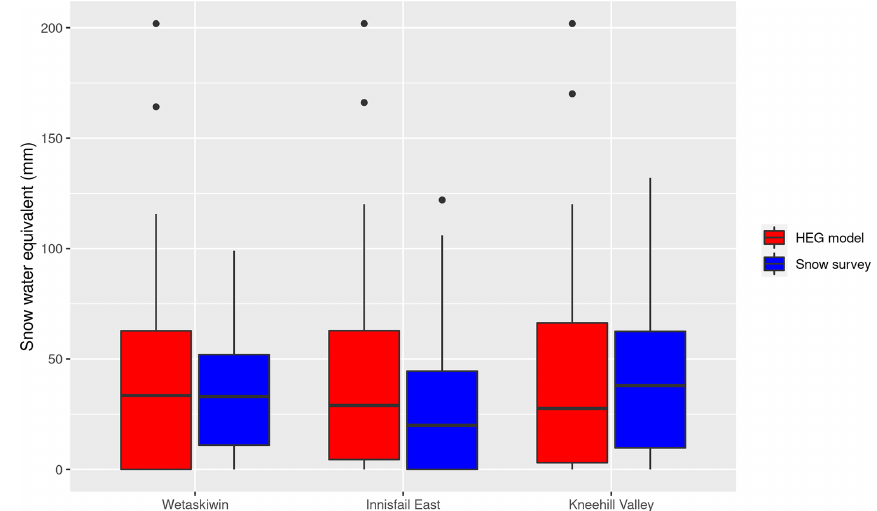
Figure 4. Comparison of 1987–2006 simulated SWE using the Red Deer climate forcings and SWE observed at the three Alberta Environ- ment and Parks (AEP) snow courses near Red Deer.